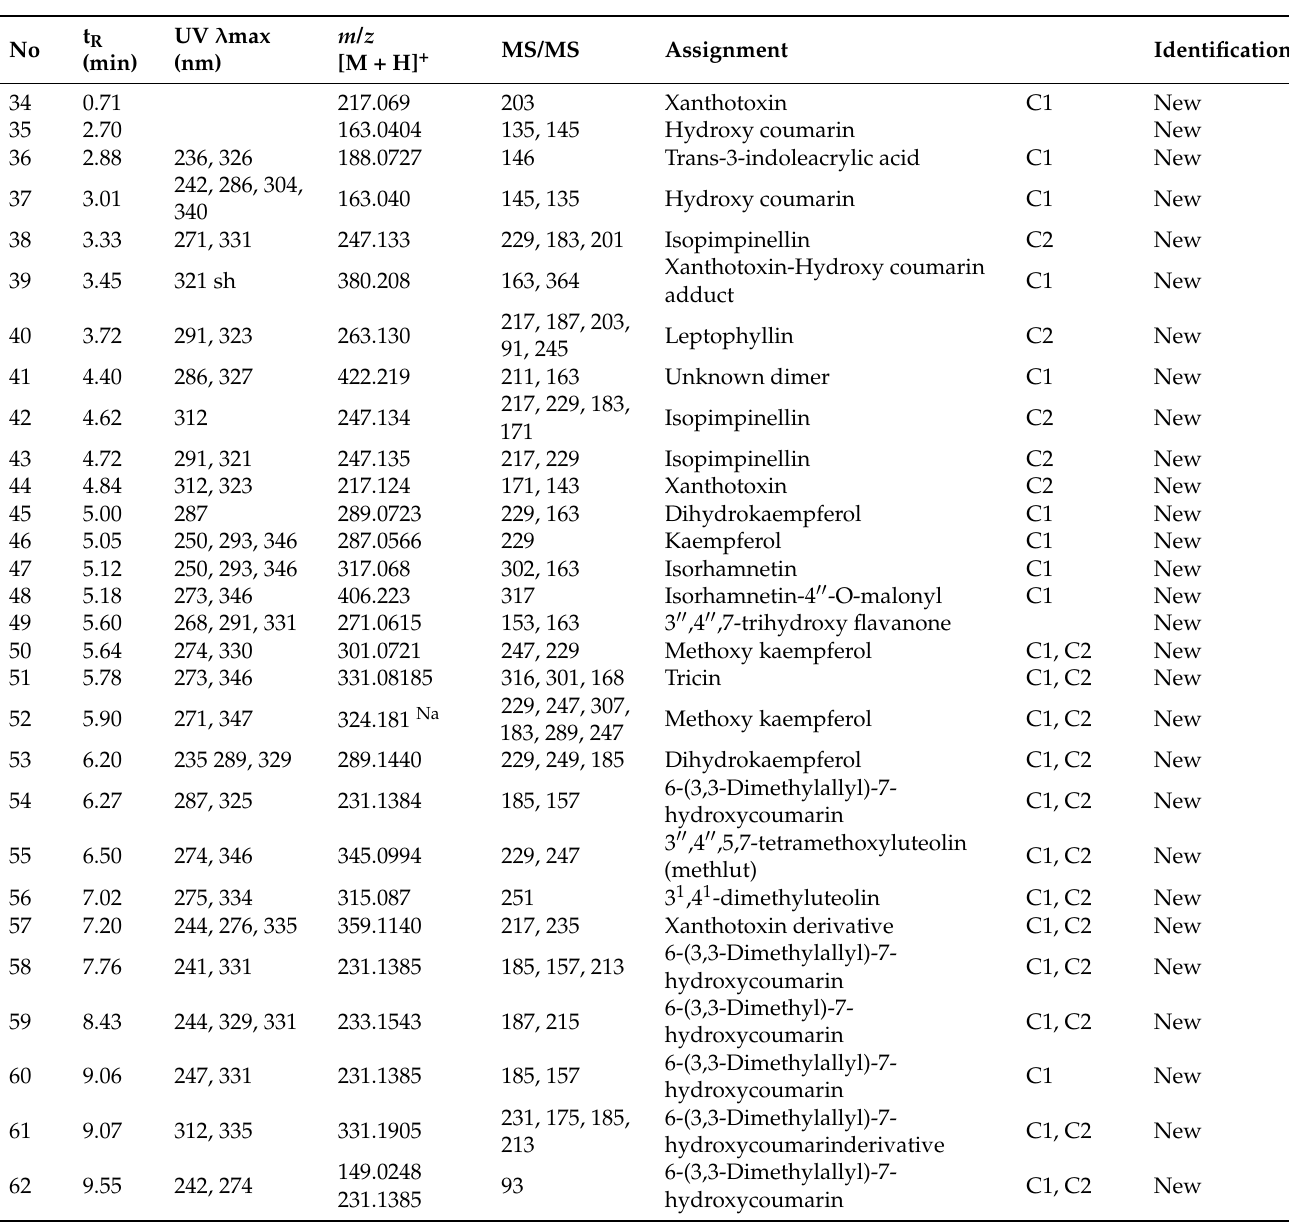
Table 3. Phytochemicals screened from the methanol (C1) and chloroform (C2) extracts of E. africanus in the positive ion